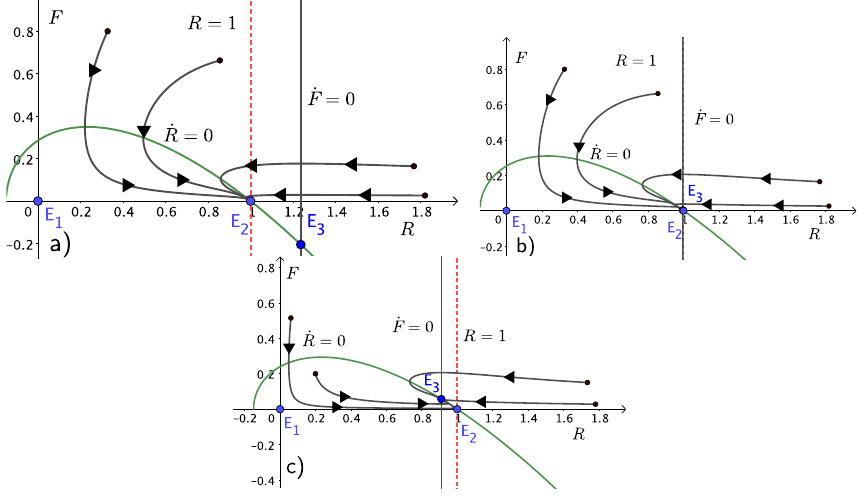
Fig. 2 (a) The transcritical and Hopf bifurcation curves, respectively, T = { ( h , µ ) , µ = µ † = 1 √ H = { ( h , µ ) , µ = µ ∗ = 1 − 2 h √ } , determine three regions in the parameter plane ( h , µ ) . The equilibrium point E 3 is 3 ( 1 + h ) unstable in (1) “saddle” and (3) “focus or node”, and stable in (2) “focus or node”. The equilibrium point E 2 is stable in (1) “node” and unstable in (2) and (3) “saddle”. (b) The curve C = { R 3 = h } determines two regions in the parameter plane ( h , µ ) . Namely, (4) region of group defense and (5) region without group defense.